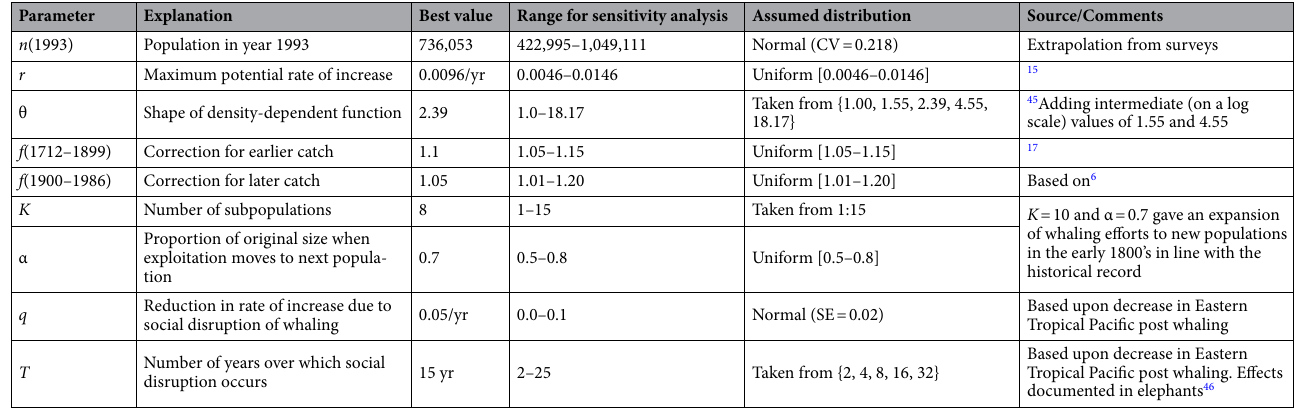
Table 4. Parameters of population